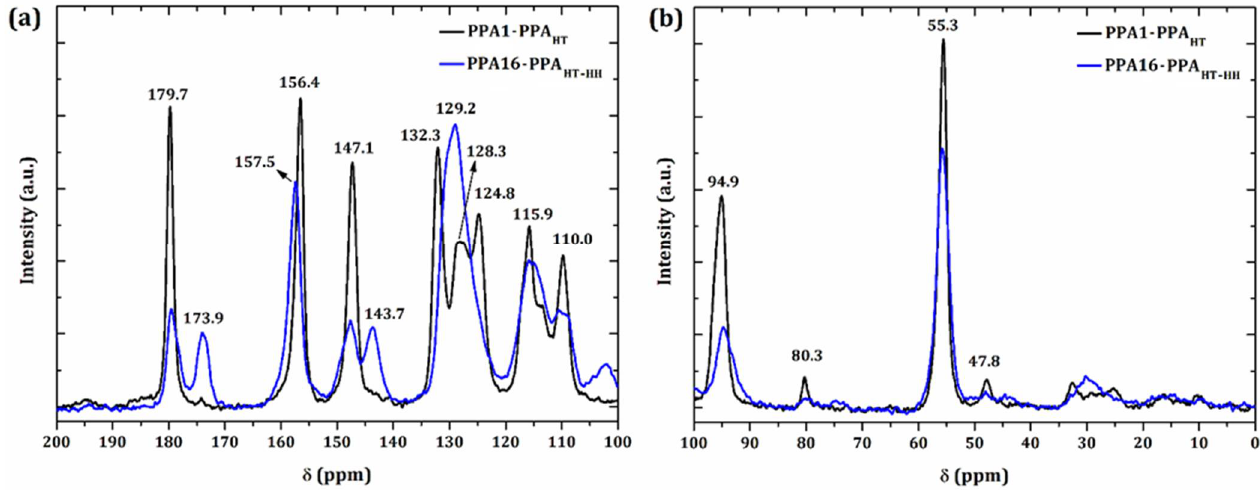
Figure 6. 13 C NMR spectra of PPA1 HT and PPA16 HT-HH : ( a ) δ = (200–100) ppm; ( b ) δ = (100–0) ppm. The observed absence of signals centered at 173.9 ppm, 143.7 ppm, and 102.0 ppm